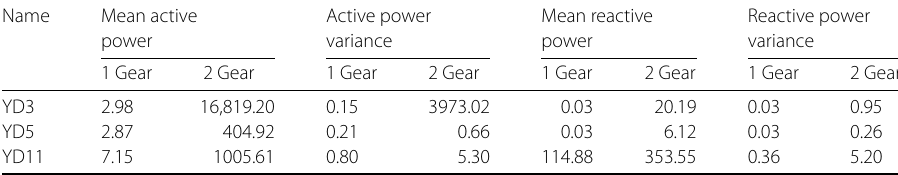
Table 3 Power load characteristics of equipment group